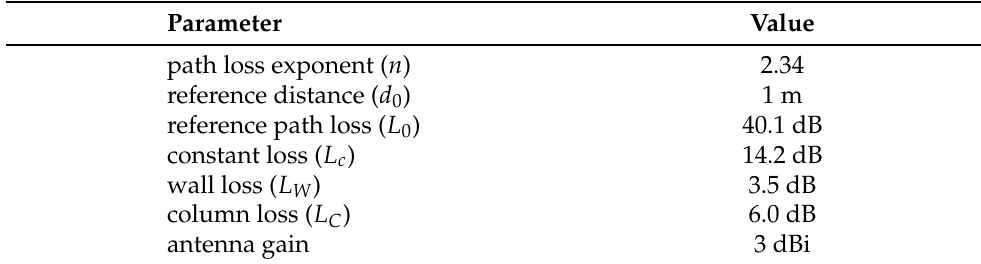
Figure 3. Sample assignment of traffic nodes to access points. Table 2. Values for the employed path loss